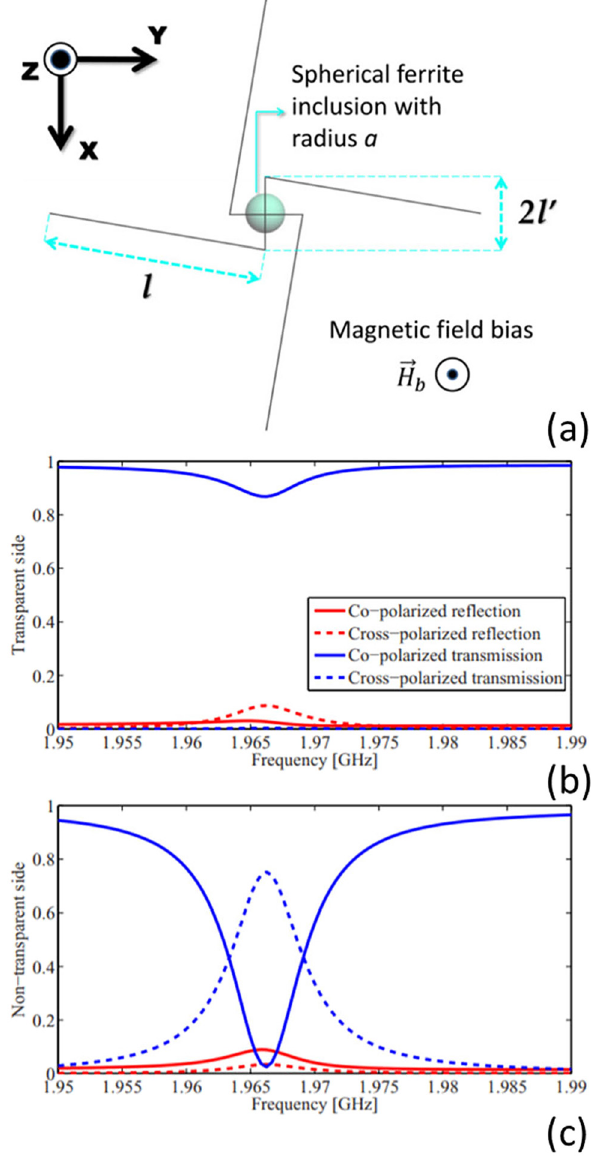
Figure32: (ReprintedwithpermissionfromRef.[124]).(a)Geometry ofaMoving – Chiralparticle.Theexternalmagnetic fi eldbiasisalong the ̂ z -axis. (b) and (c) Simulated re fl ection and transmission (in terms of intensity) for the sheet when the incident wave propagates along the (b) transparent side and (c) nontransparent